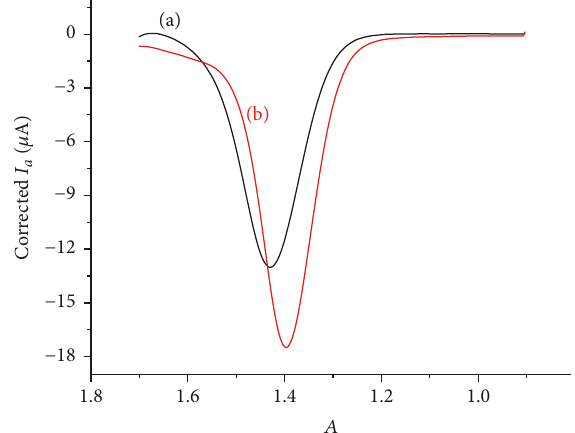
Figure 4: Differential pulse voltammograms (corrected for back- ground) of unmodified (a) and modified (b) GCE in pH 4.0 ABS containing 1mM